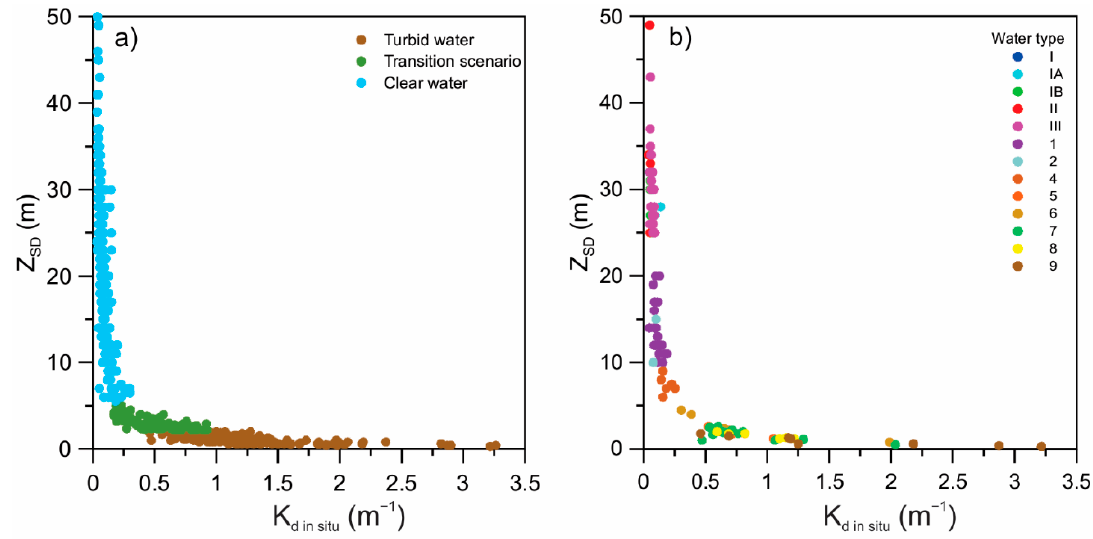
Figure 4. ( a ) Relationship between 𝑍 (cid:3020)(cid:3005) and 𝐾 (cid:3031) ( b ) relationship between 𝑍 (cid:3020)(cid:3005) and 𝐾 (cid:3031) absorption data).